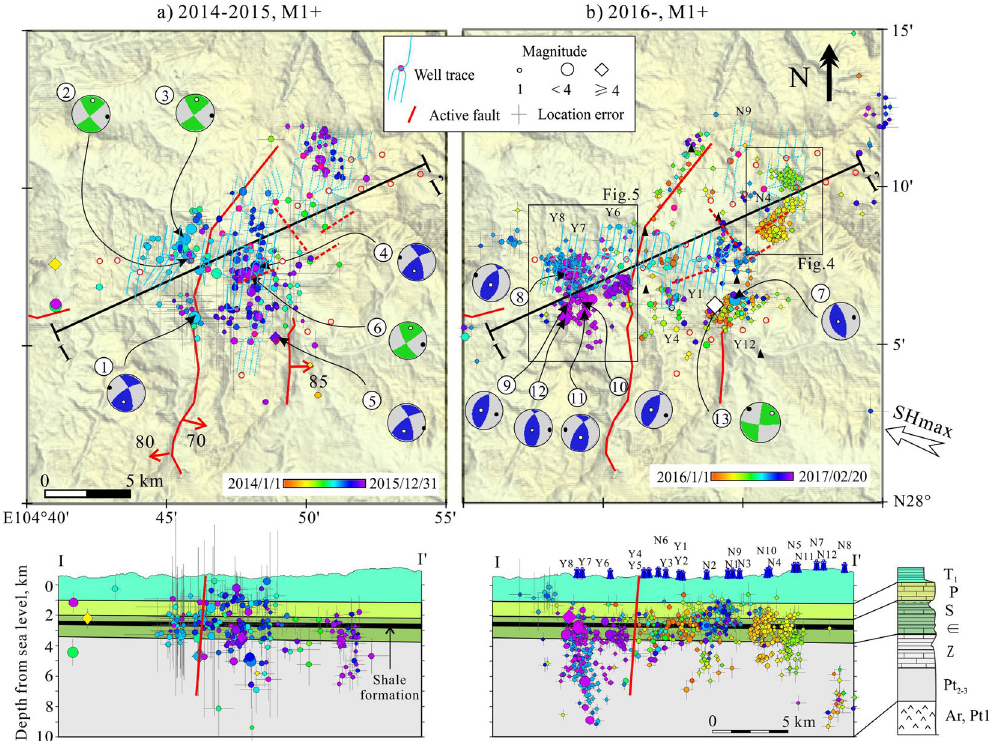
Figure 3. Map and section views of relocated earthquakes for two periods: ( a ) Jan. 1, 2014 through 2015, and ( b ) since Jan. 1, 2016, with the focal mechanisms of the largest earthquakes ( M w ≥ 3.5). The earthquake symbols are colored by date and scaled for magnitude. The gray cross lines show vertical and the horizontal errors given by the relocation program. The red arrows and numbers on the faults indicate the dip direction and dip angle of the fault. The big inward-pointed arrow shows the orientation of the maximum horizontal principal stress (SHmax). This map was created using the free software GeoTaos_map (developed by Xinglin Lei; https://staff. aist.go.jp/xinglin-lei/) and finished with the software CorelDRAW × 8. (Copyright ( c ) 2016 Corel Corporation. All rights